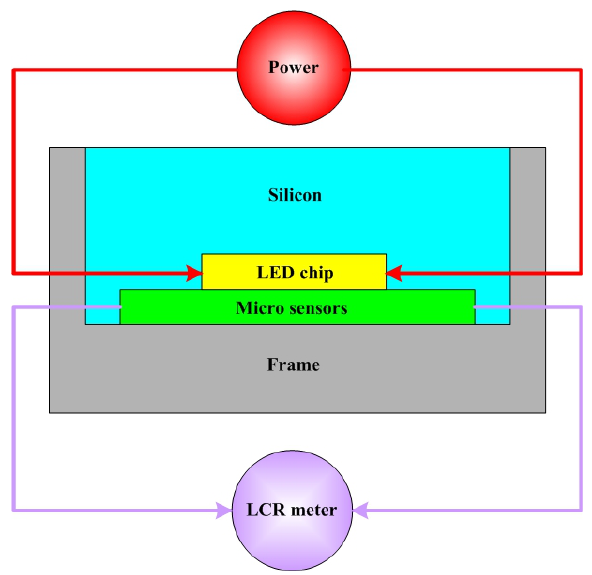
Figure 8. Illustration of micro sensors in LED.